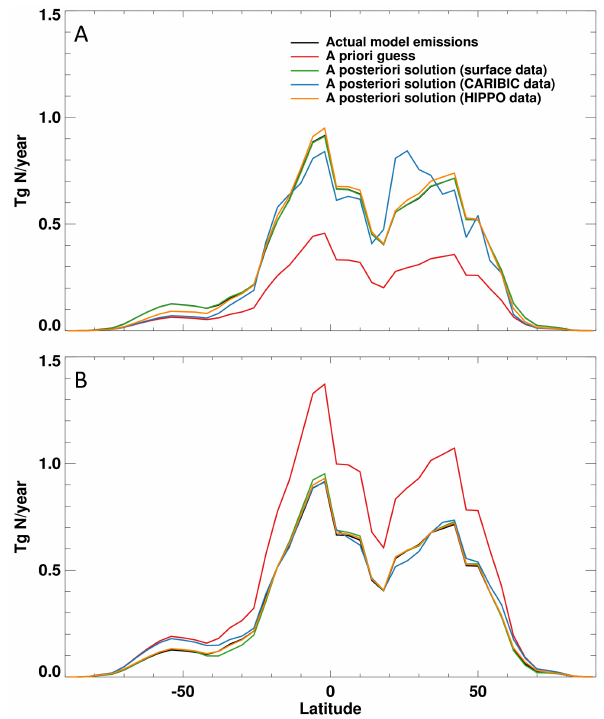
Figure 5. Pseudo observation tests optimizing N 2 O emissions. Shown are zonally integrated annual emissions for the first year of the simulation (April 2010–March 2011) starting with an a priori scaling factor of (a) 0.5 and (b) 1.5, where the true value is 1.0. Ac- tual model emissions are shown in black, model emissions scaled by the a priori guess are shown in red, and a posteriori emissions obtained using surface data, CARIBIC data, and HIPPO data are shown in green, blue, and orange,